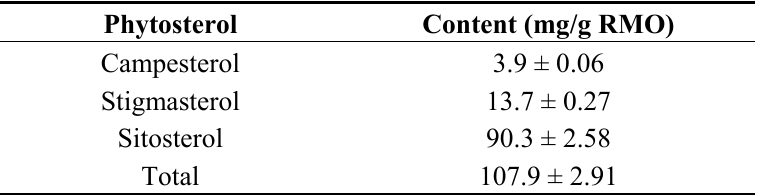
Table 1. Phytosterol contents in red ginseng mark